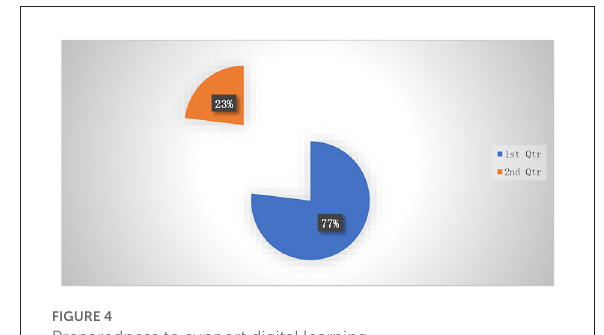
FIGURE4 Preparedness to support digital